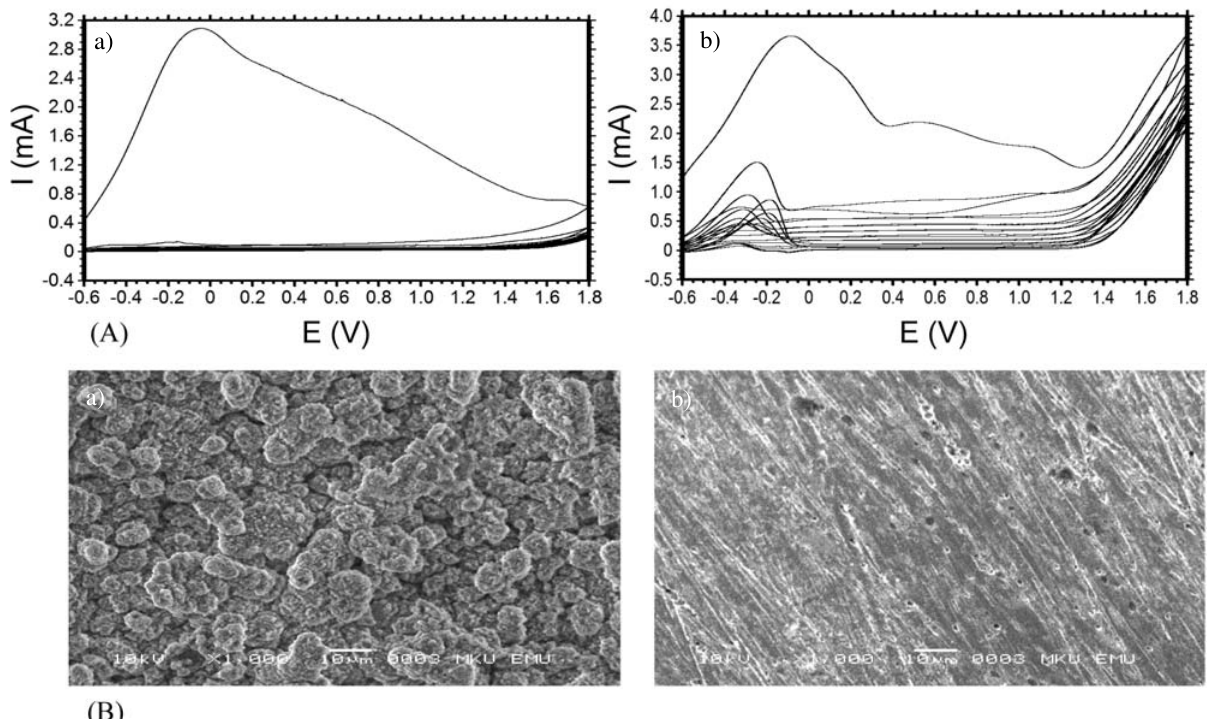
Fig. 5. Film growth curves (A) and SEM images (magnification: 1000) (B) of layers obtained on CS/ZnFeCo electrode in a) 0.20 M NaOX b) 0.20 M NaTart solution, scan rate: 50 mV s –1